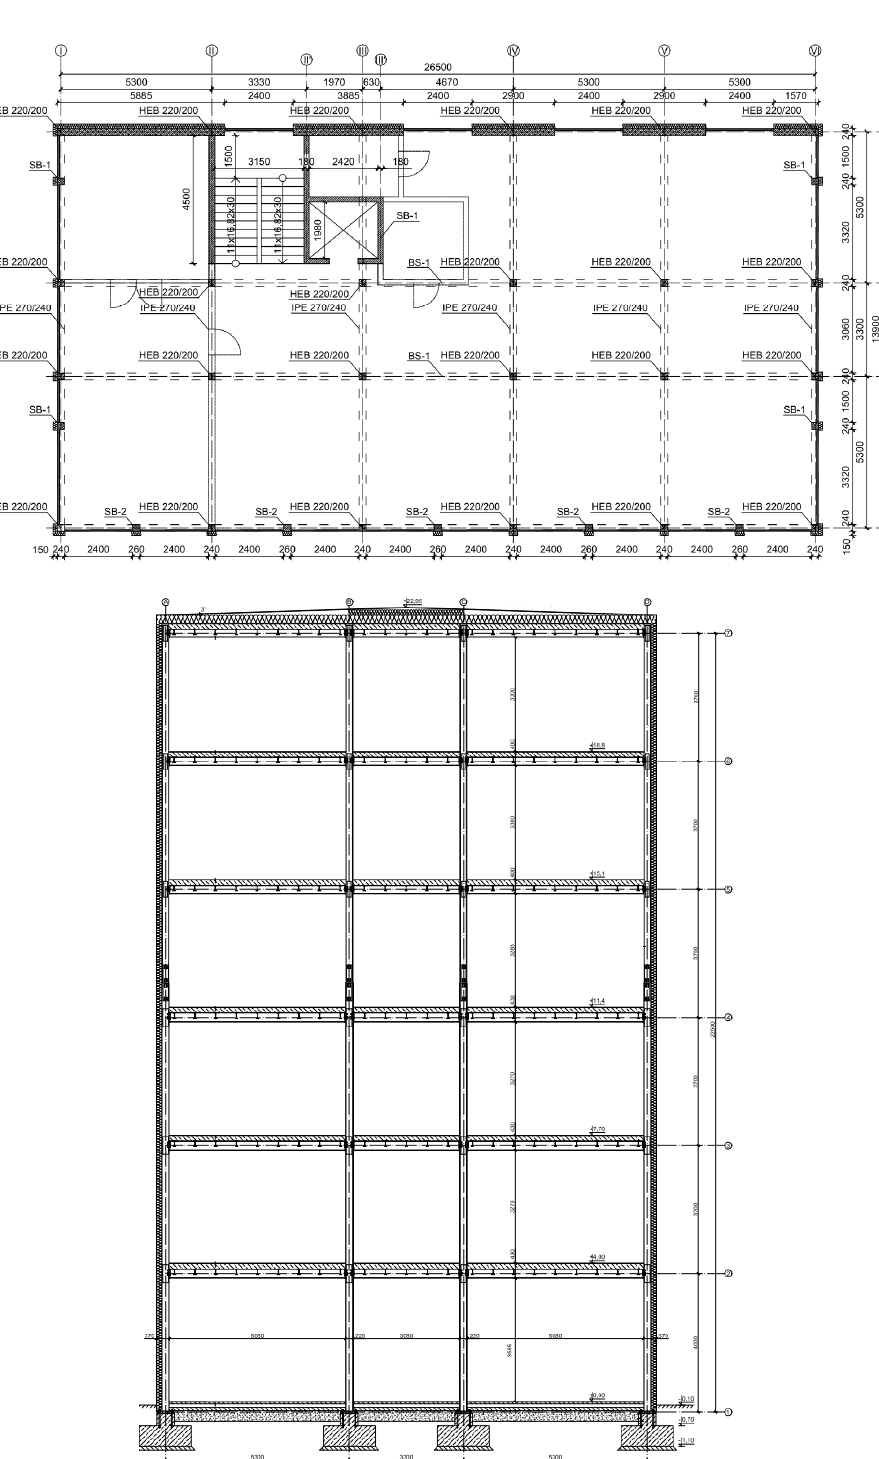
Figure 3. Layout of the building plan with internal partitions and building structure.